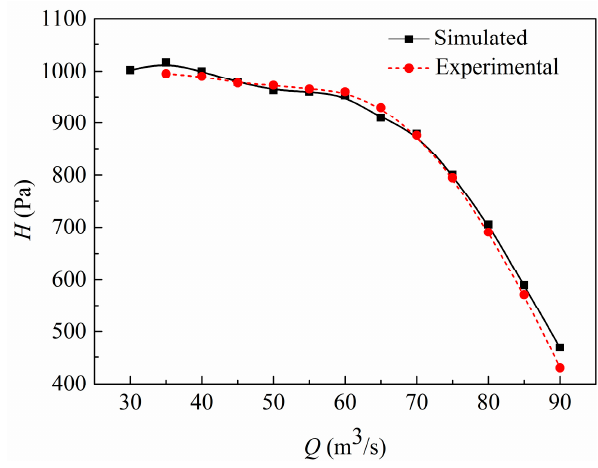
Figure 5. Comparison of experimental and numerical performance curves.